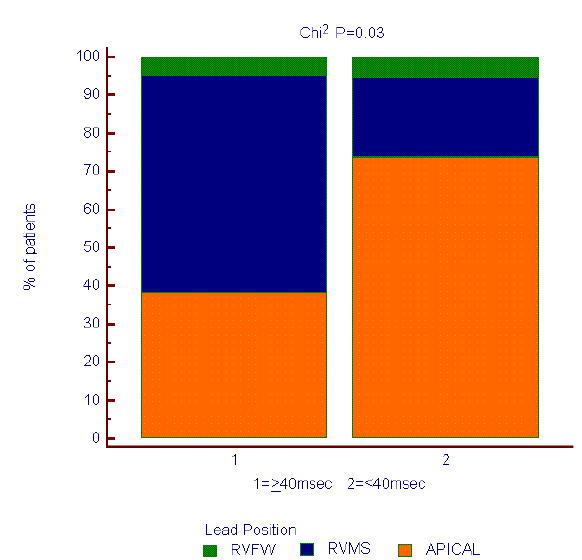
Fig. 8 - Interventricular dyssynchrony and pacing